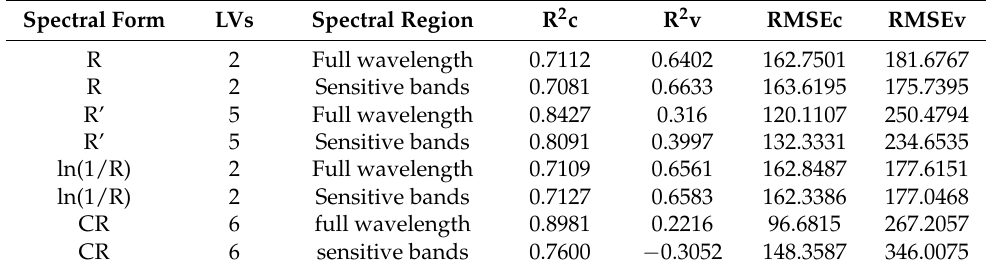
Table 2. The estimation accuracy of PLS models.